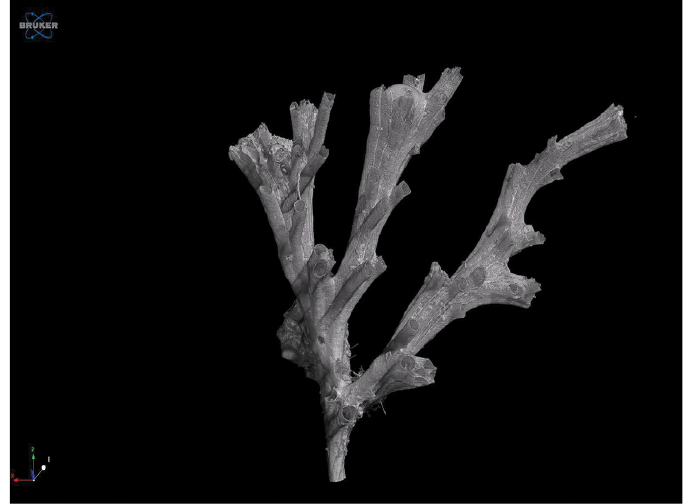
Figure 11. Video of the 3D-model of Hastingsia irregularis Borg, 1944 (MNA 10490) and Arachnopusia sp. (MNA 10491). Height and width of the H. irregularis colony are respectively ~5.1 mm and ~6.2 mm.